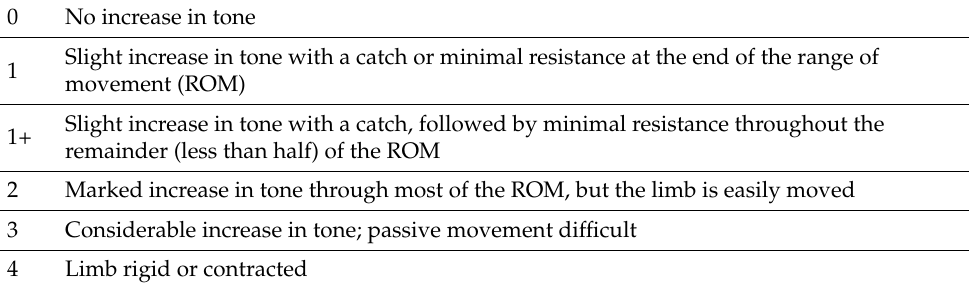
Table 2. Modified Ashworth